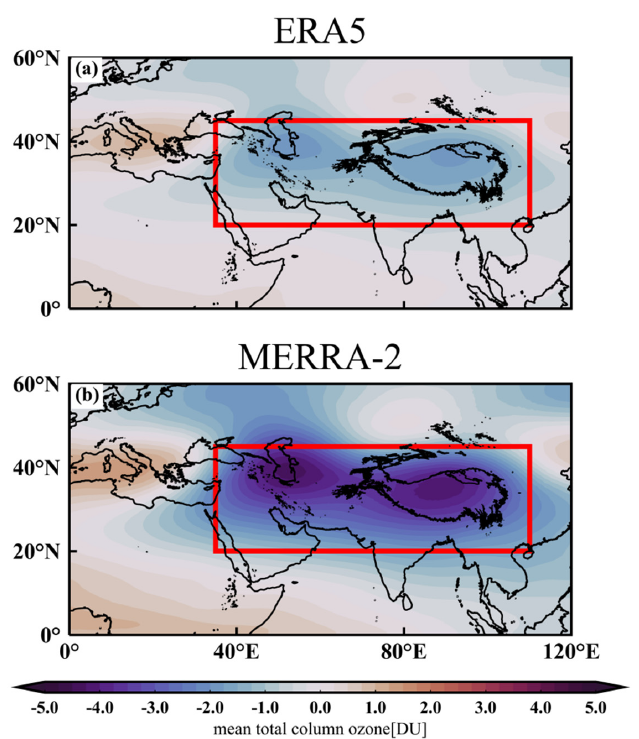
The ozone valley over the Tibetan Plateau is mainly distributed in the UTLS [34]. the UTLS and shows the spatial distribution of the time-averaged TCO* from 1979 to 2021.